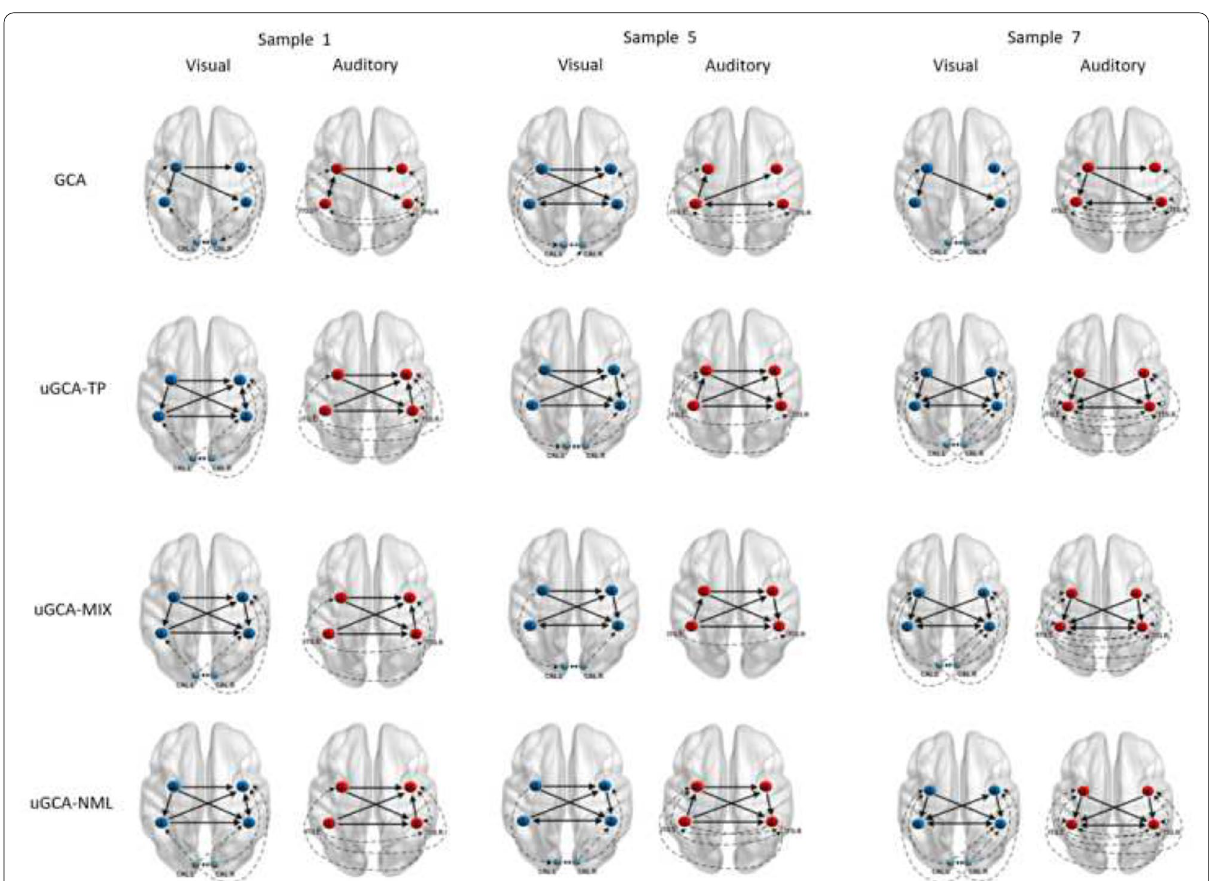
Fig. 6 Causal network in the mental arithmetic tasks obtained by uGCA methods and conventional GCA, respectively. With the conventional GCA approach, connected edges of causal networks in two different stimuli were to a large extent distinct. In contrast, for uGCA methods, their connection networks commonly showed high similarities. Node 1, 2, 3, 4 was involving the inside network of mental arithmetic tasks. As for different stimuli input nodes, they were CAL.L, CAL.R, ITG.L, and ITG.R, respectively. The solid lines represent causal connectivities within the mental arithmetic network, and the dashed lines represent causal connectivities involving the input stimulus